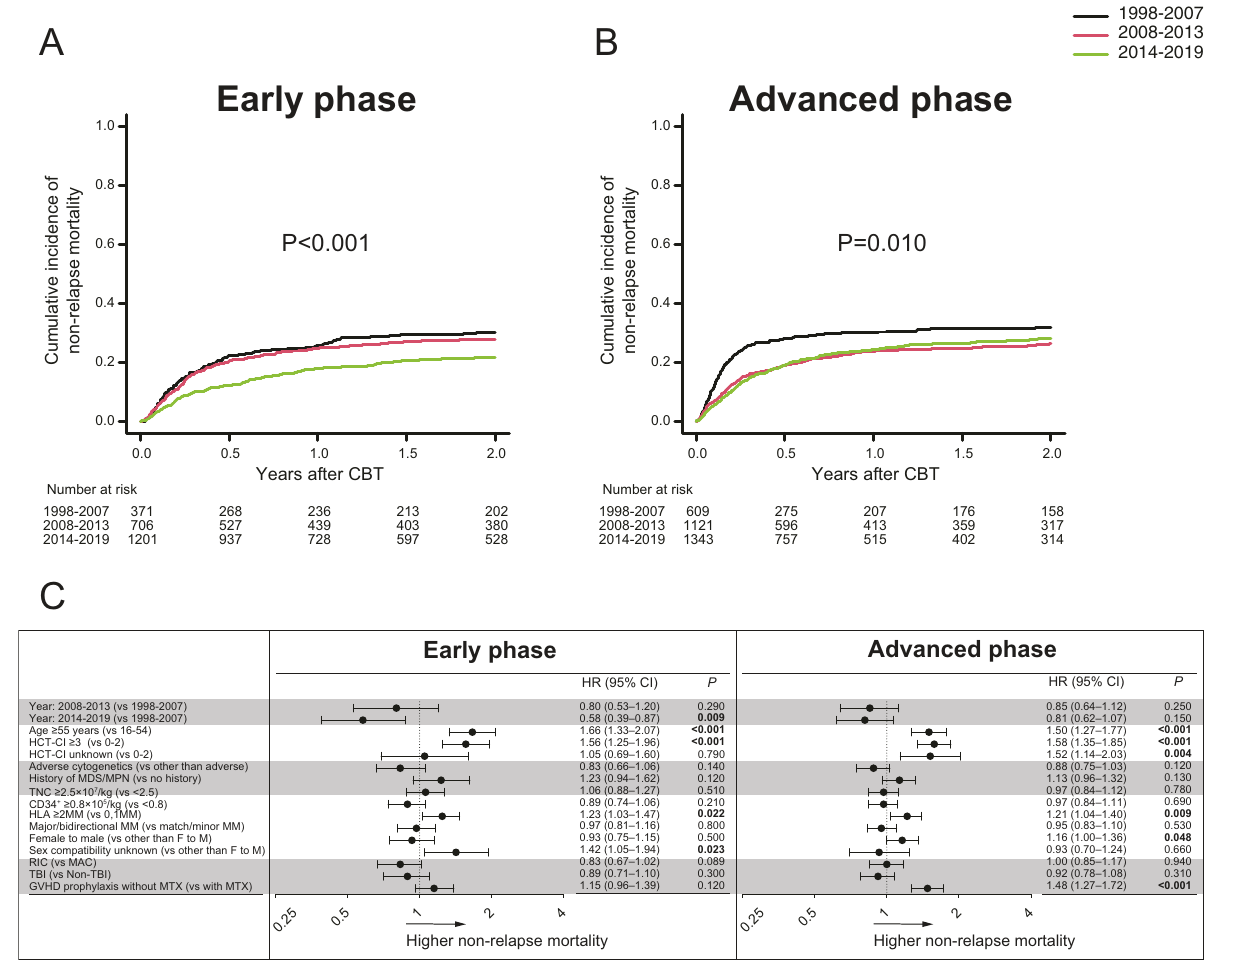
Fig. 4 Non-relapse mortality after CBT according to disease status at CBT. The cumulative incidences of non-relapse mortality after CBT according to the three time periods in patients with early phase at CBT ( A ), or advanced phase at CBT ( B ). Forest plots of the adjusted hazard ratios (HR) and 95% con fi dence intervals (CI) of non-relapse mortality among each cohort in the multivariate analysis ( C